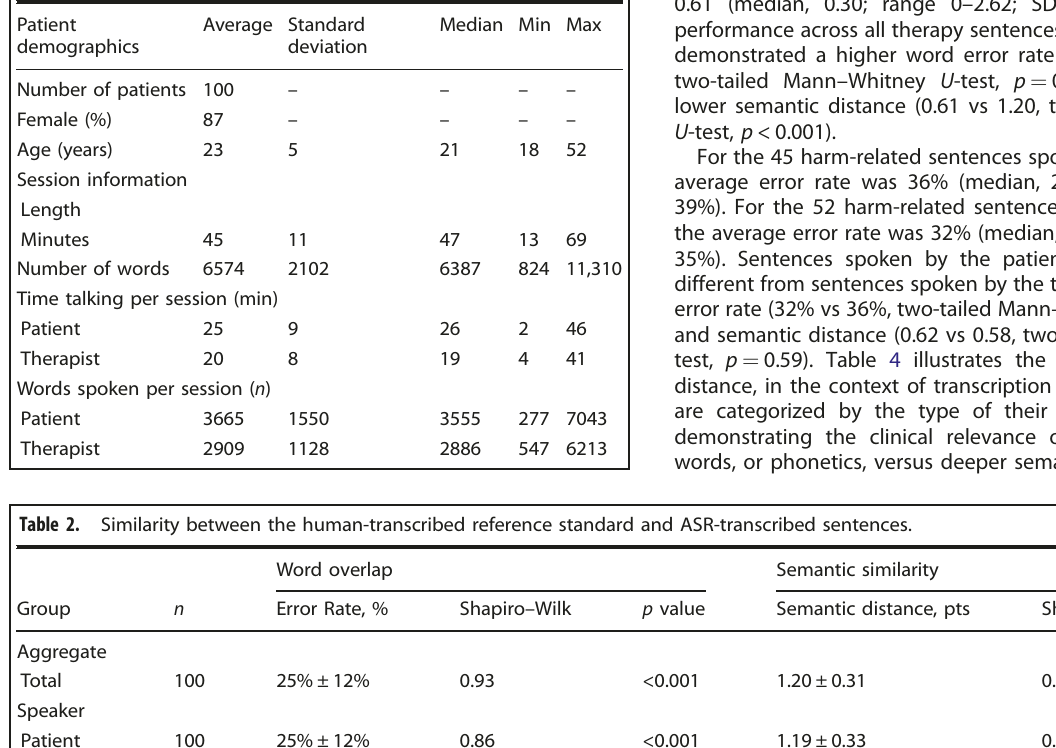
Table 1. Patient demographics and therapy session information.